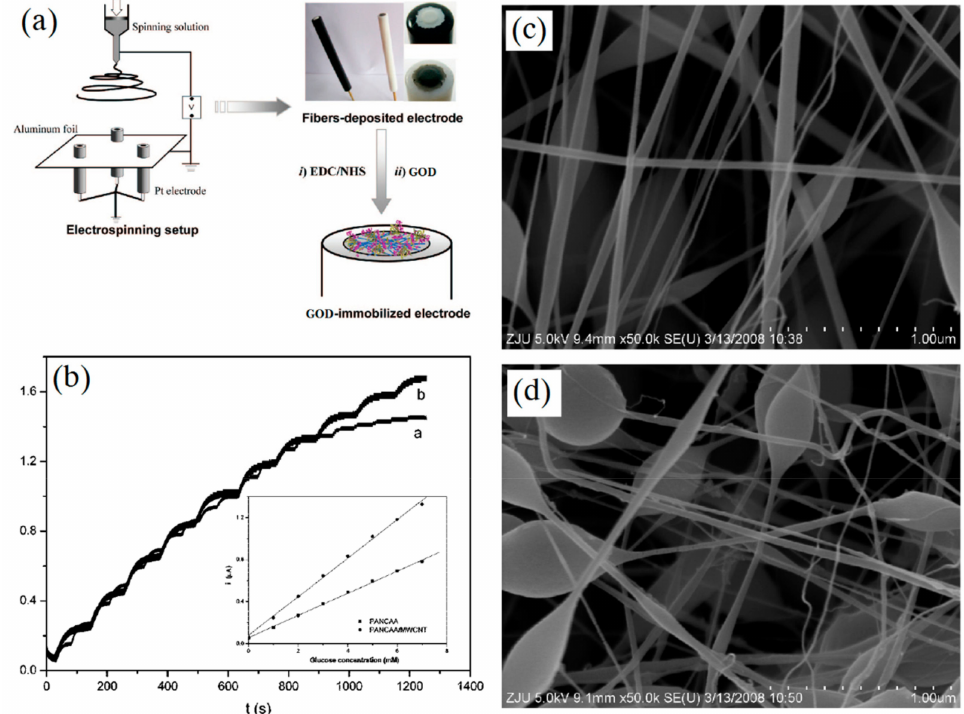
Figure 4. Electrospun MWCNT filled PANCAA enzyme electrochemical sensor for glucose sensing: ( a ) Schematic presentation of electrospinning for GOD electrode; ( b ) amperometric curves with various glucose concentrations; ( c ) SEM images of electrospun PANCAA NFMs; ( d ) SEM images of electrospun MWCNT filled NFMs. (reproduced with permission from reference